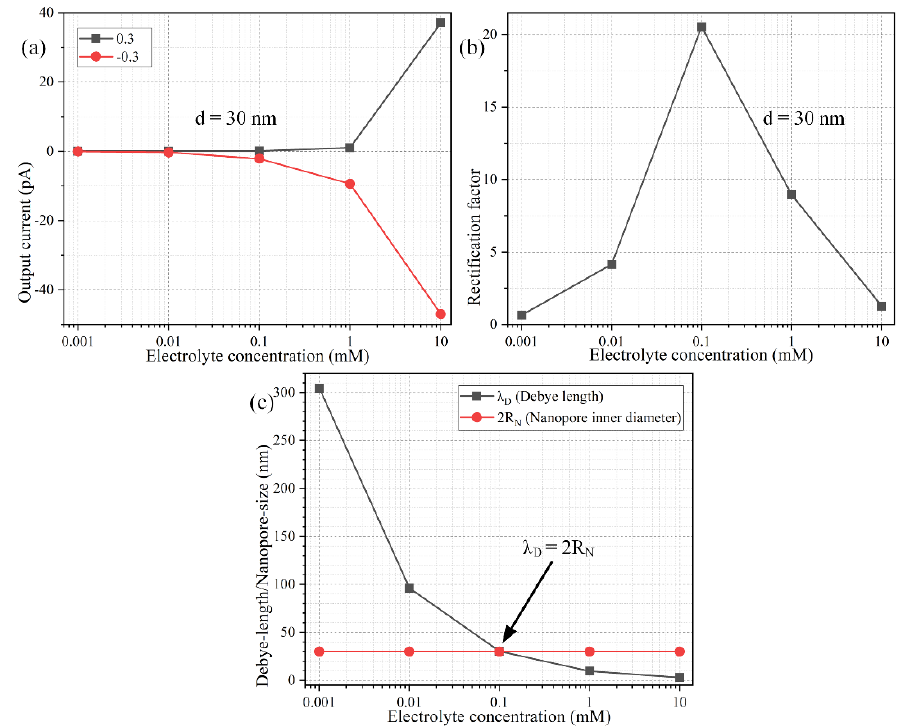
Figure 8. Influence of electrolyte concentration of the working fluid on the rectification performance of the nanofluidic ion diode, under a given parametric space of V S = ±0.3 V, L C = 600 nm, σ free = −0.001 C/m 2 , and R N = 15 nm. ( a ) The forward and backward output ion current and ( b ) rectification factor, as a function of the background salt concentration. ( c ) Theoretical estimation of the electrolyte-concentration dependence of the Debye length, against the constant nanopore inner diameter.